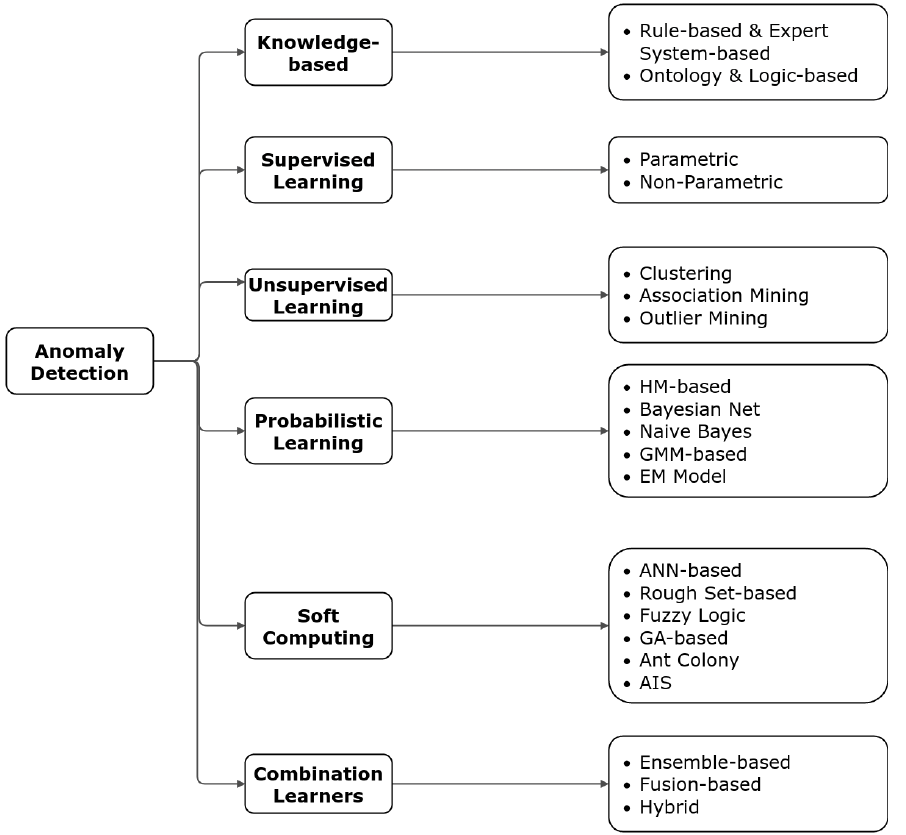
Figure 6. Types of network anomaly detection